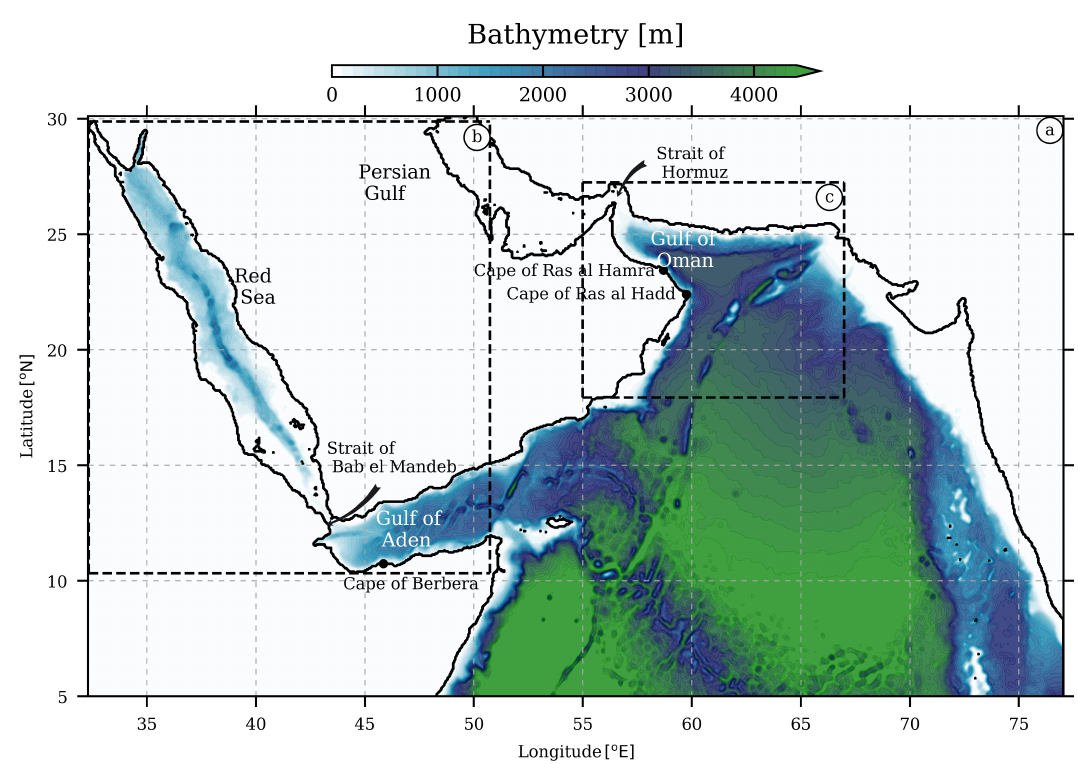
Figure 1. Bathymetry of the Arabian Sea ( a ). The domains used for the two AGRIF zooms are displayed in dashed black lines ( b , c